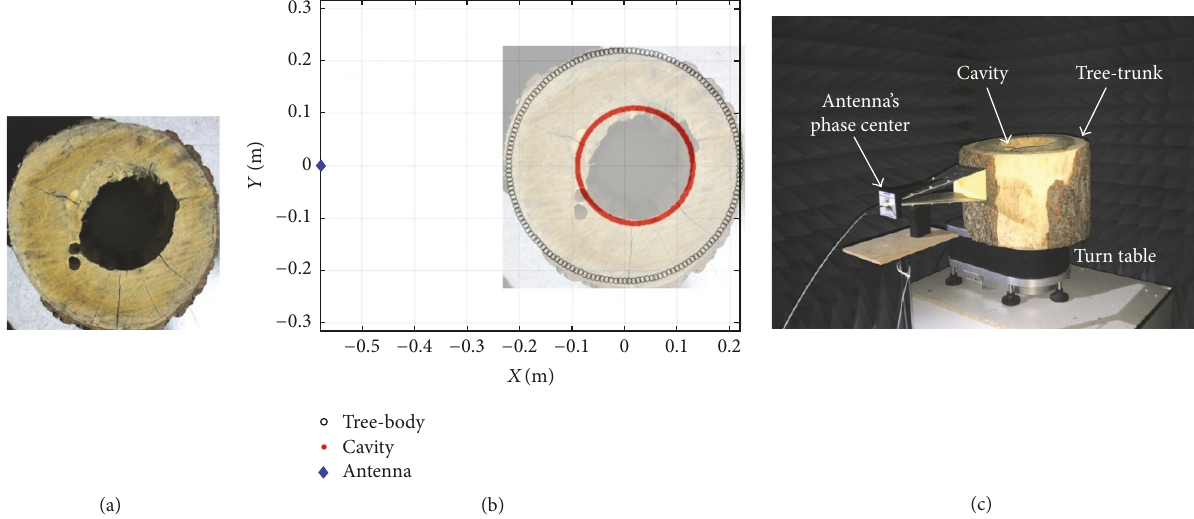
Figure 5: (a) Picture of the piece of pine tree trunk, (b) simulation scenario for the experiment, and (c) picture from the real TIIR experiment.